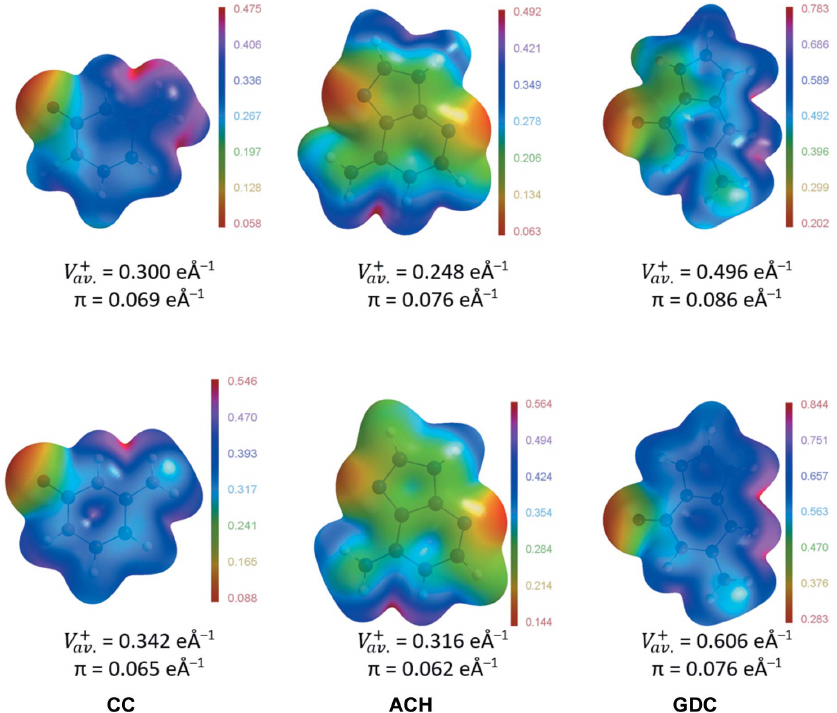
Figure 7 Electrostatic potentials (e A˚ (cid:4) 1 ) of (top) nucleobases in the studied crystals from experimental charge densities or (bottom) isolated nucleobases bearing formal charges as modelled by UBDB , mapped on the respective electron-density isosurfaces at (cid:12) = 0.0135 e A˚ (cid:4) 3 (= 0.002 a.u.). V þ average of the positive surface values and (cid:2) is the average deviation from the average positive surface value (Politzer et al. ,